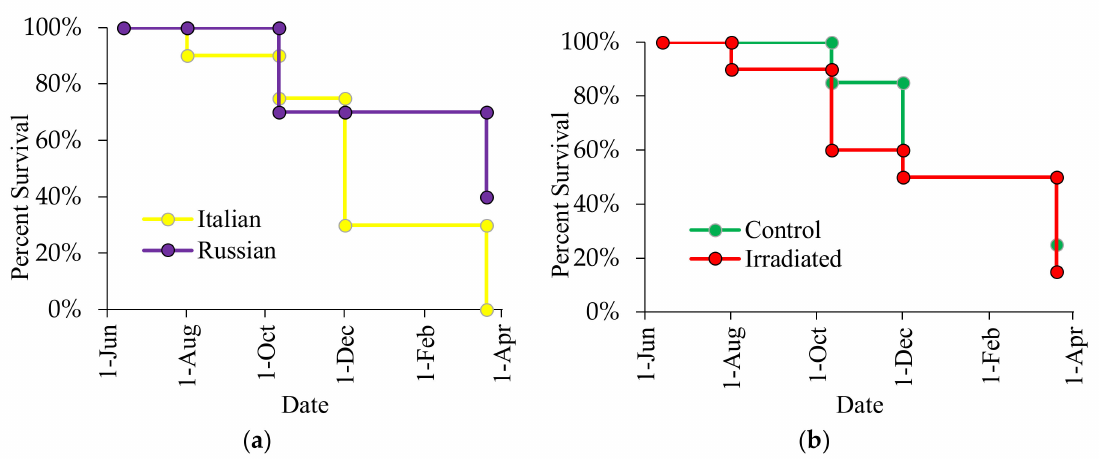
Figure 11. Effects of honey bee stock ( a ) and comb irradiation ( b ) on colony survival in